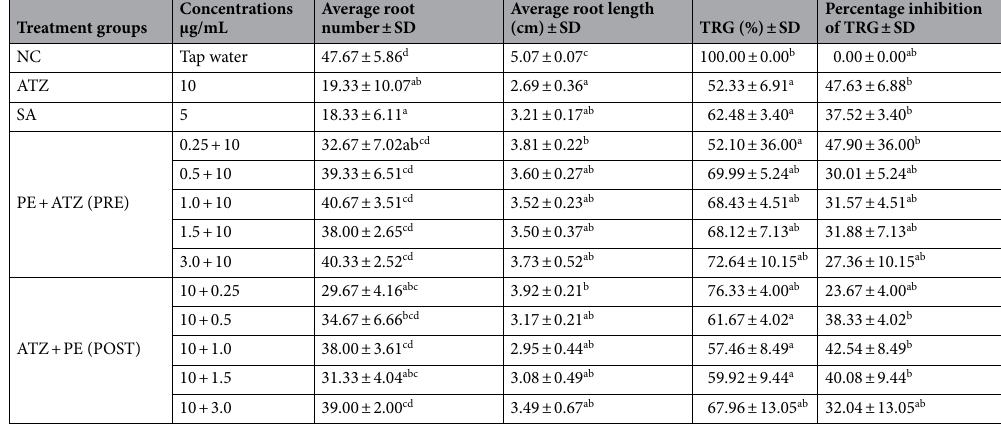
Table 7. Combine effects of atrazine, sodium azide and plant extract on Allium cepa root growth. NC negative control, ATZ atrazine, SA sodium azide, PE plant extract, TRG total root growth. Data are mean ± SD of three replicates. Different alphabets (a, b, c and d) are significantly different at (p < 0.05), as determined by Tukey HSD test.